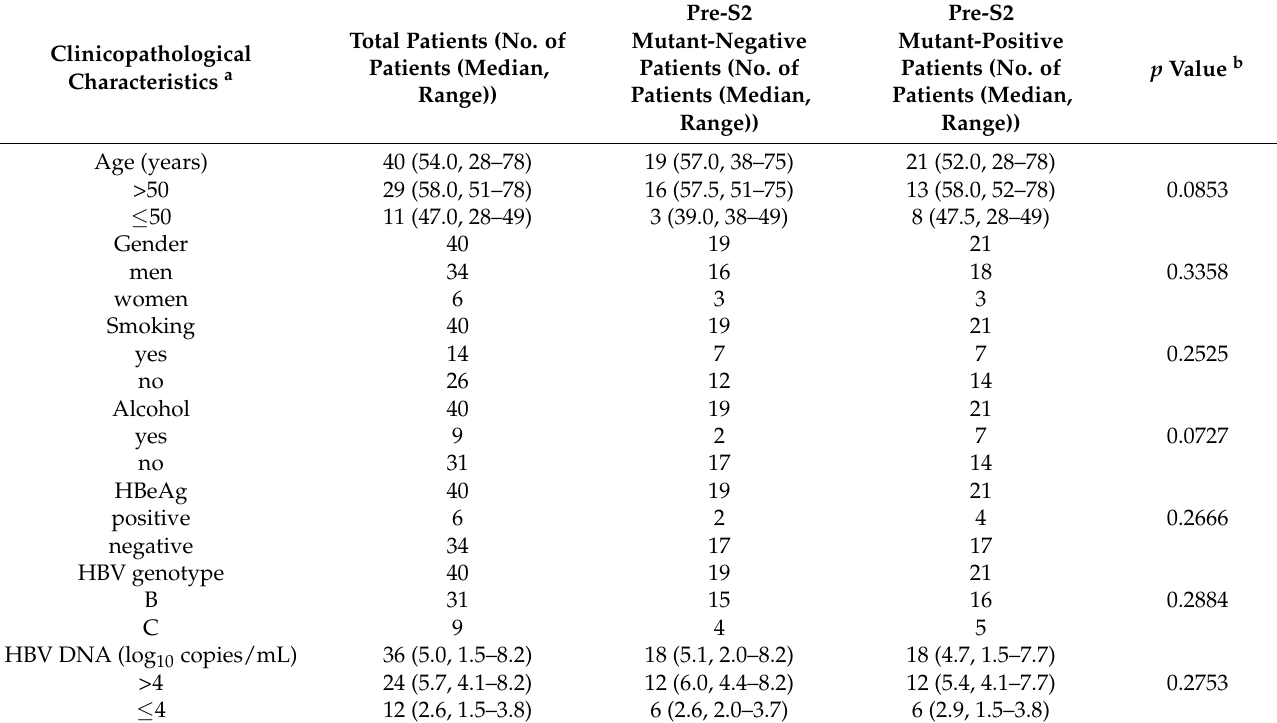
Table 1. Clinicopathological profiles and correlation of the 40 HBV-related HCC